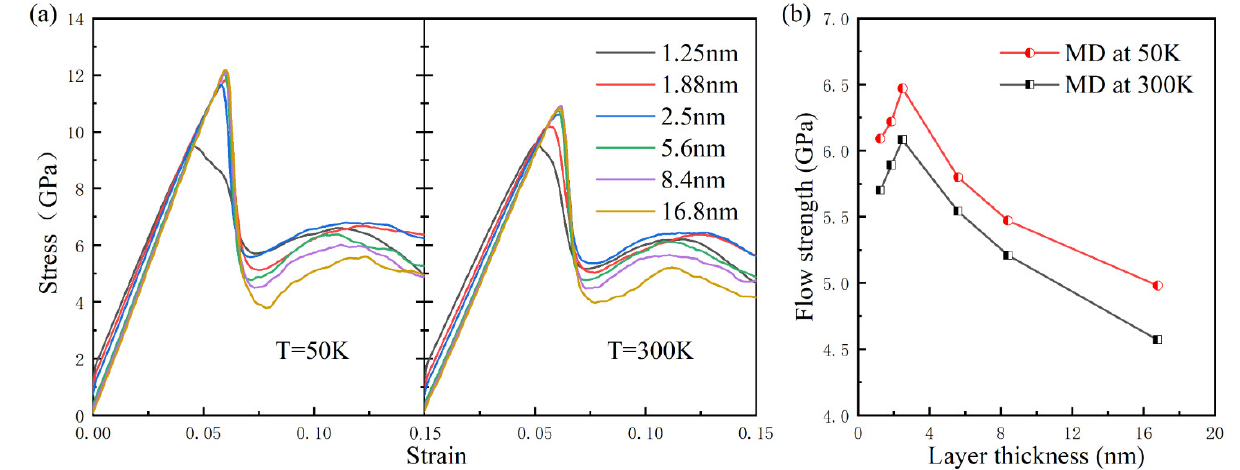
Figure 1. ( a ) Stress–strain curves for compressed samples with different layer thicknesses at 50 K and 300 K. ( b ) The average flow strength of the MD for samples of different layer thicknesses.